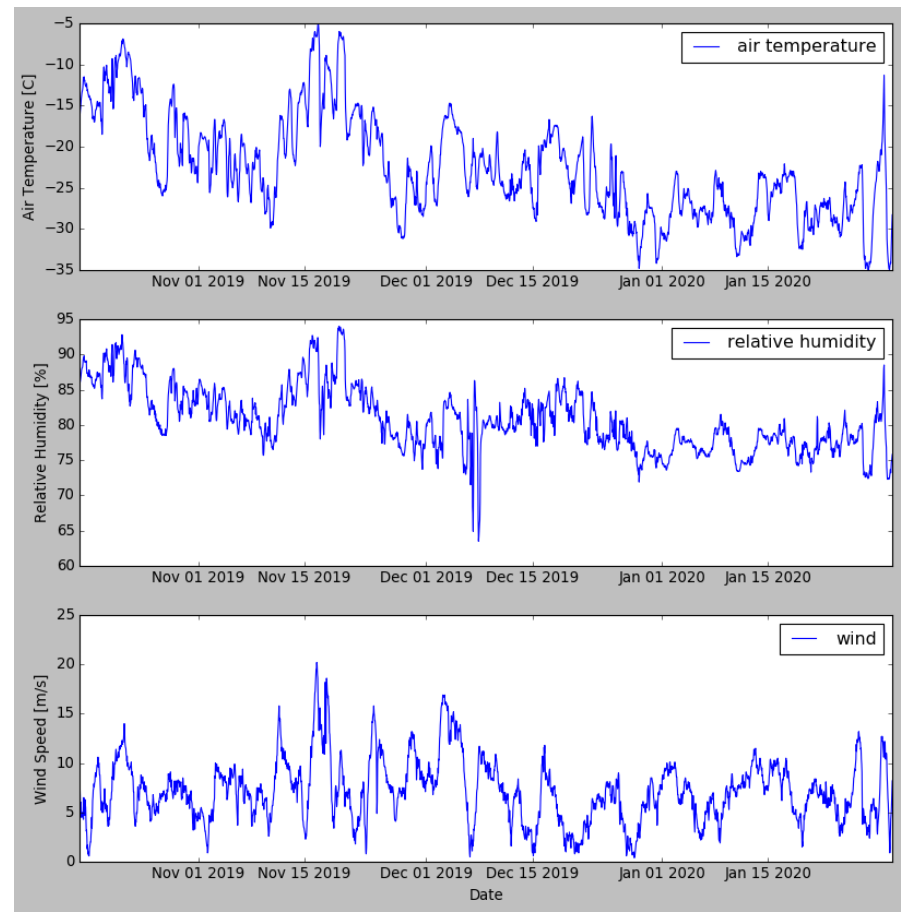
Figure 3. Summary of weather data during deployment of KuKa radar, measured from R/V Polarstern . Shown are the air temperature, relative humidity and the wind speed from 18 October 2019 to 31 January 2020 at 30m